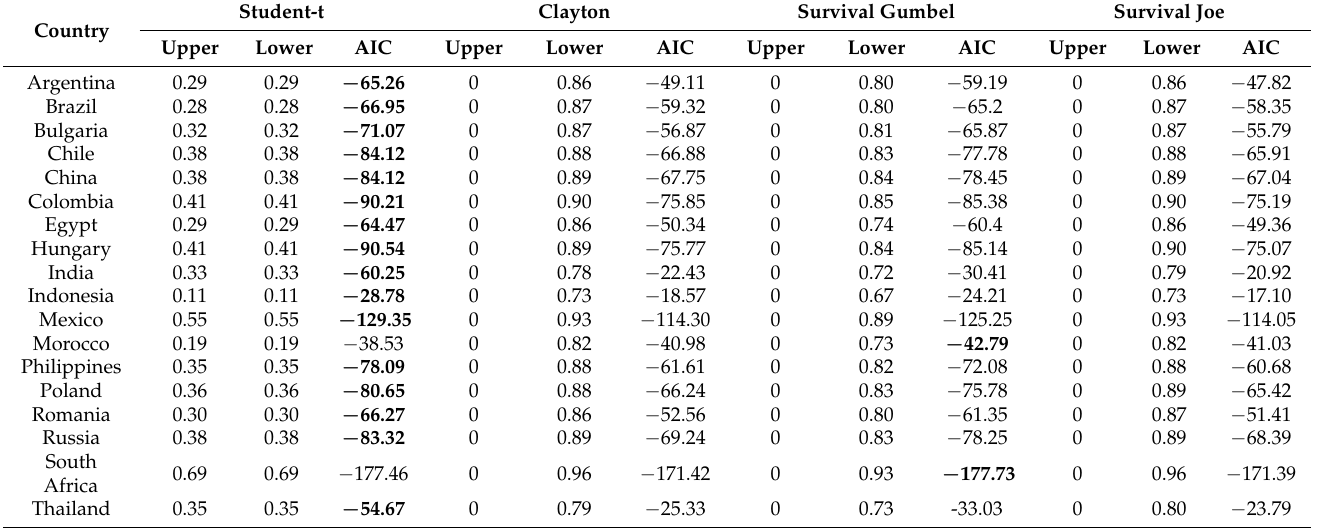
Table 4. Model comparison and tail